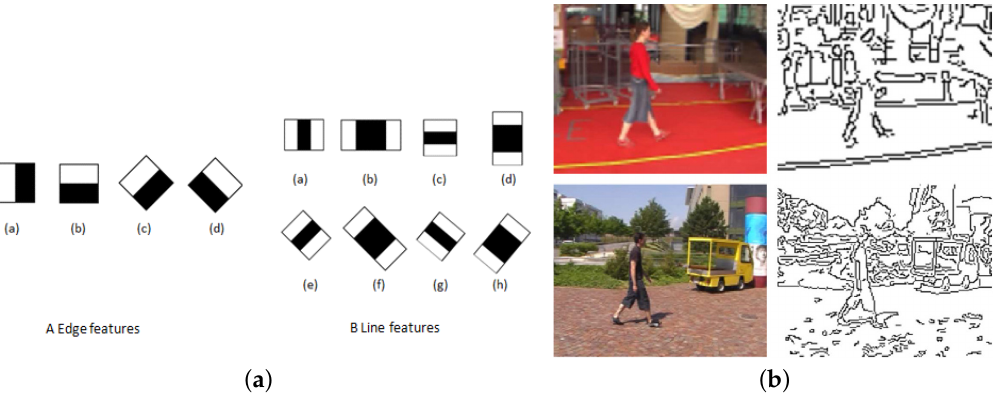
Figure 2. Edge Filter and Extracted Edge Feature Examples. ( a ) Haar Filters as Edge Filters; ( b ) Edge Features in